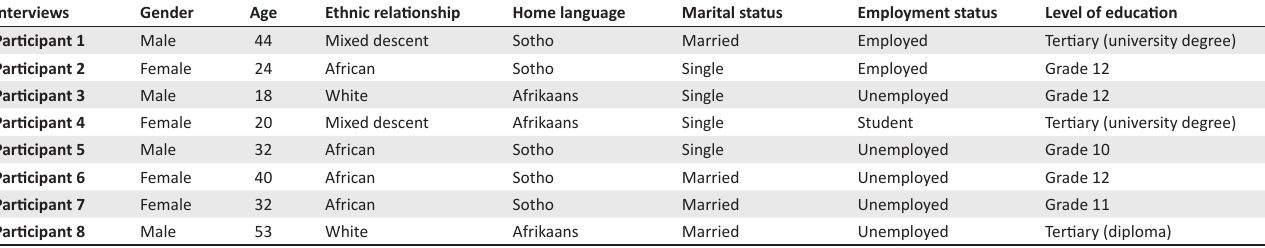
TABLE 1: Demographic data of patients with mood disorders who attended group therapy by psychiatric nurses.